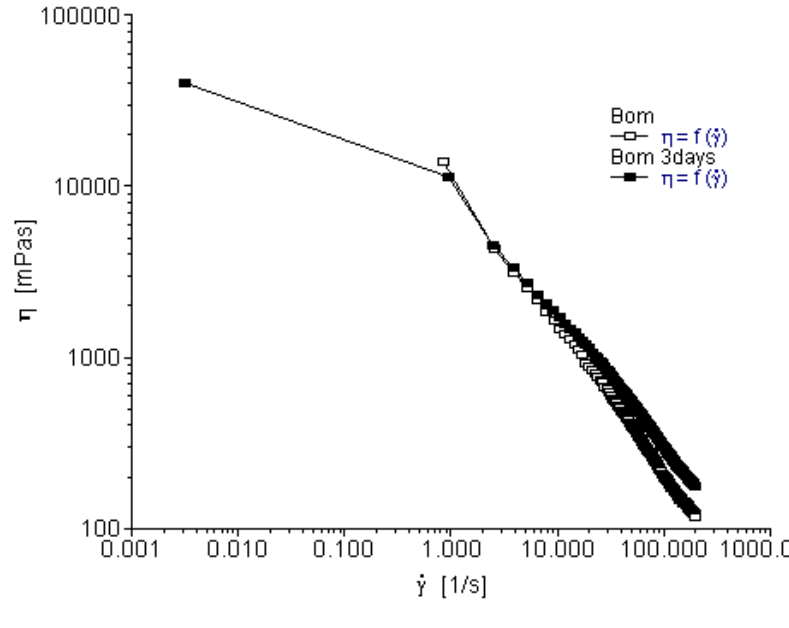
Figure 2. Viscosity as a function of shear rate for bombax